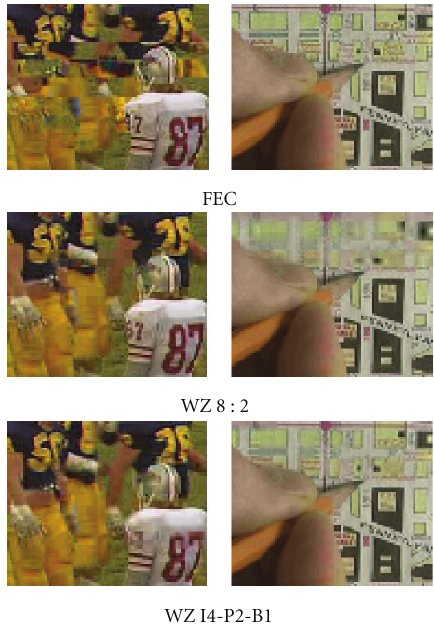
Figure 6: Displayed frame from FEC, WZ 8:2, and WZ I4-P2-B1 for Football (left) and Map (right)